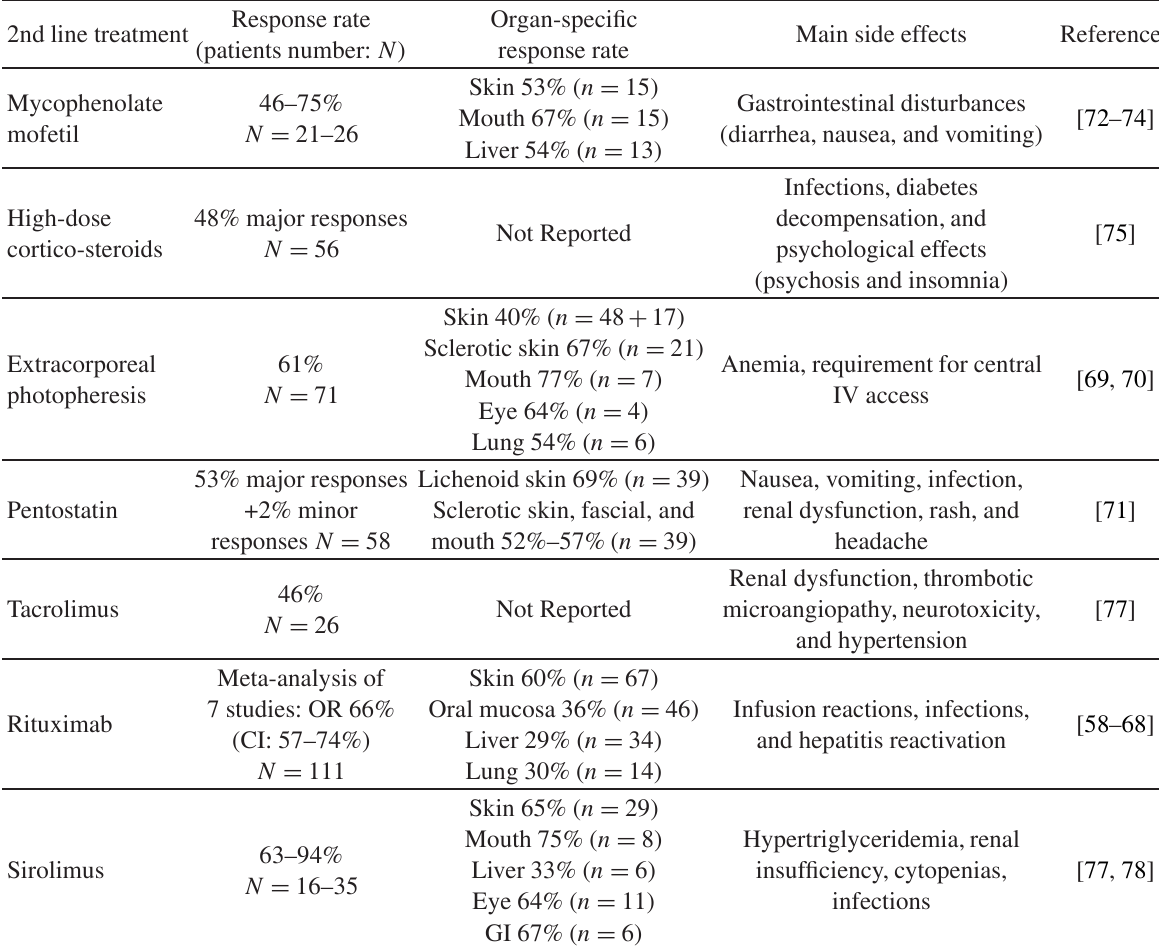
TABLE 1: Response rate and outcome reported in the main clinical trials for patients with refractory